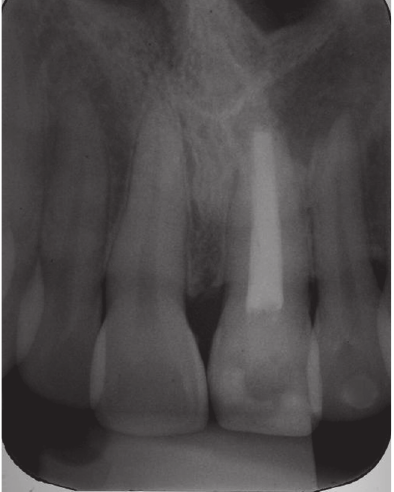
Figure 4: Root canal final filling with a MTA-based endodontic cement.